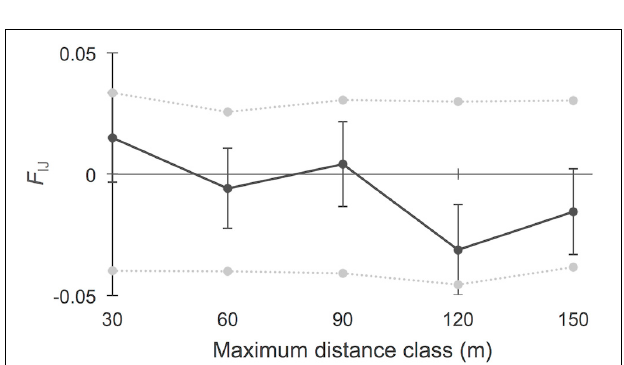
FIGURE 3 | Fine-scale genetic structure of Avicennia marina populations ( N = 6) from sheltered mangroves in bays in the Western Indian Ocean region. Five distance classes of 30 m interval showed significant kinship ( F IJ ) values for the first distance classes (*** p < 0.001; ** p < 0.01). The slope of the regression over 150 m was b = –0.56 ( p < 0.001).